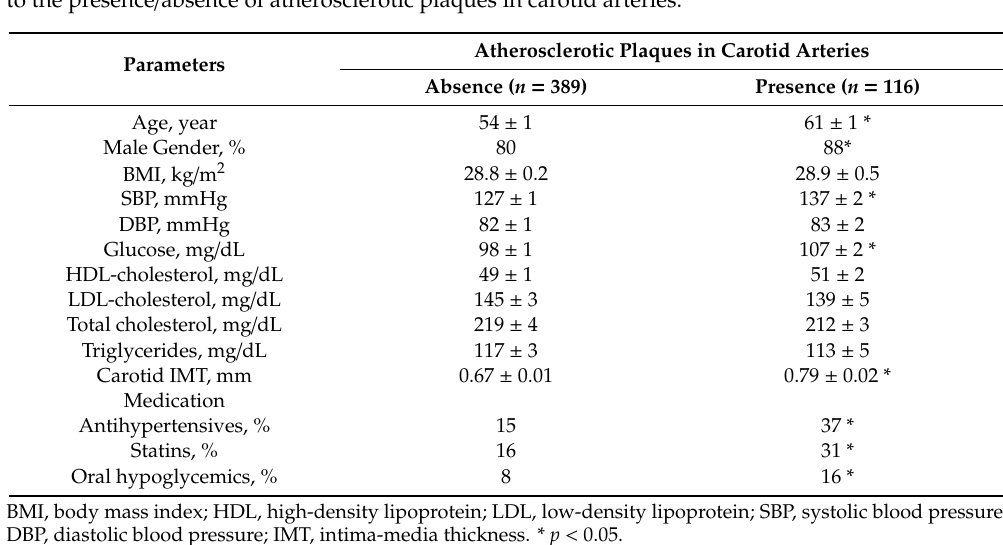
Table 1. Demographical and clinical characteristics of the cohort 1 (asymptomatic subjects) according to the presence / absence of atherosclerotic plaques in carotid arteries.